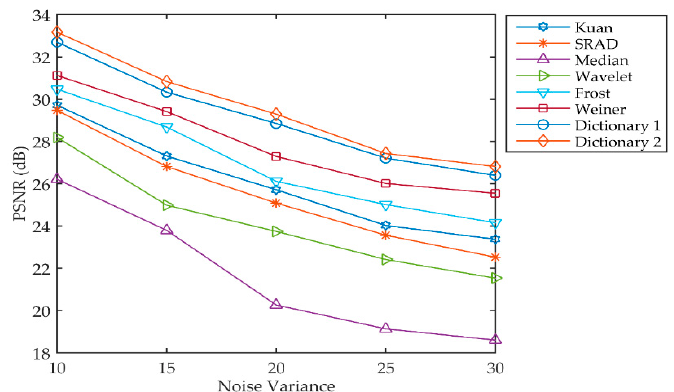
Figure 8. Comparison of PSNRs obtained by different methods. SRAD: speckle reducing anisotropic diffusion.